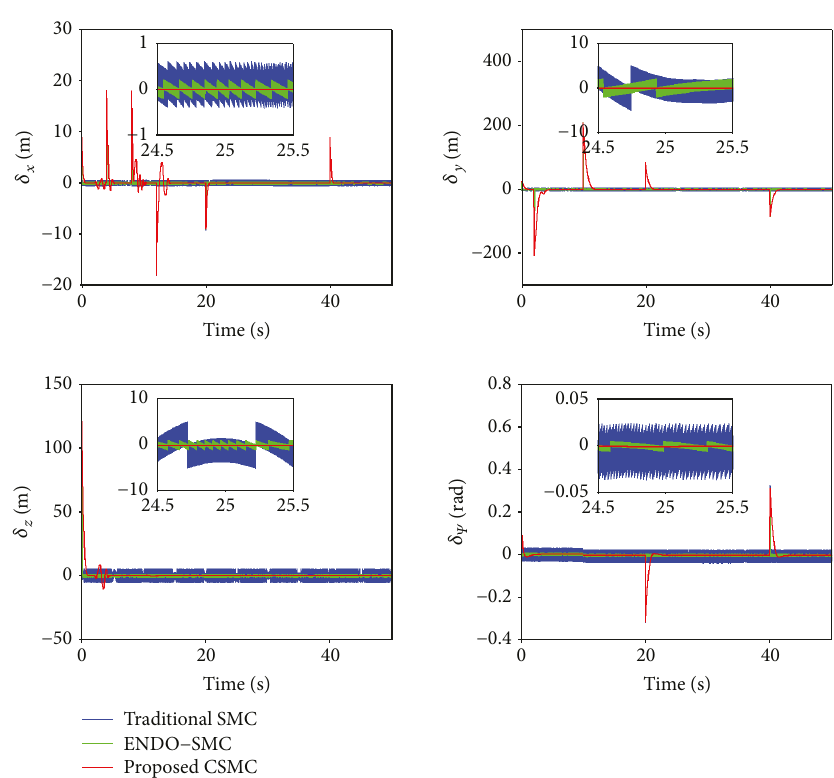
Figure 12: The response curves of sliding surfaces of maneuver.